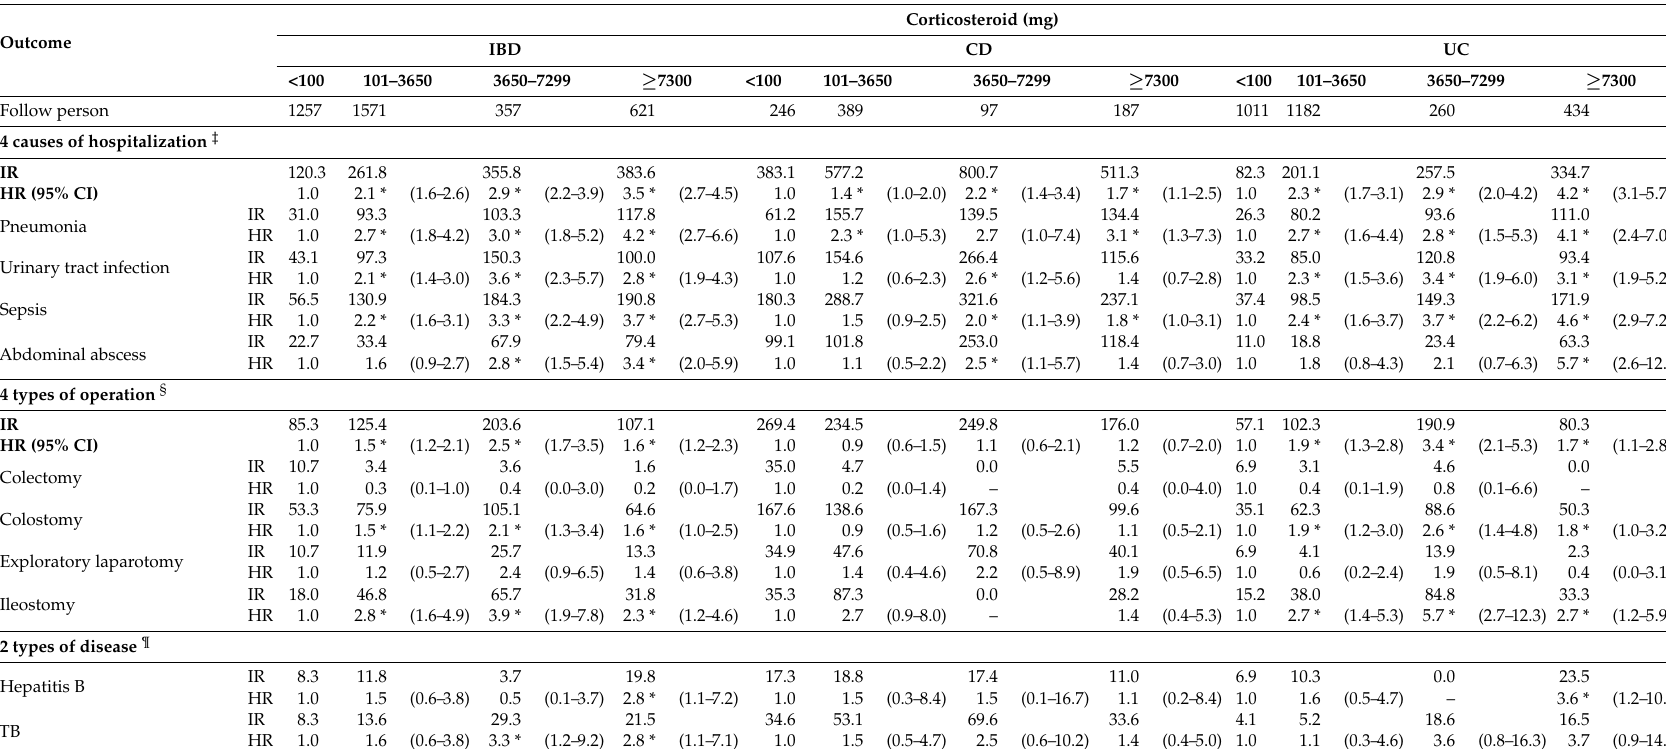
Table 5. Risks of operation, hospitalization, and related diseases associated with corticosteroid therapy among patients with IBD in Taiwan,